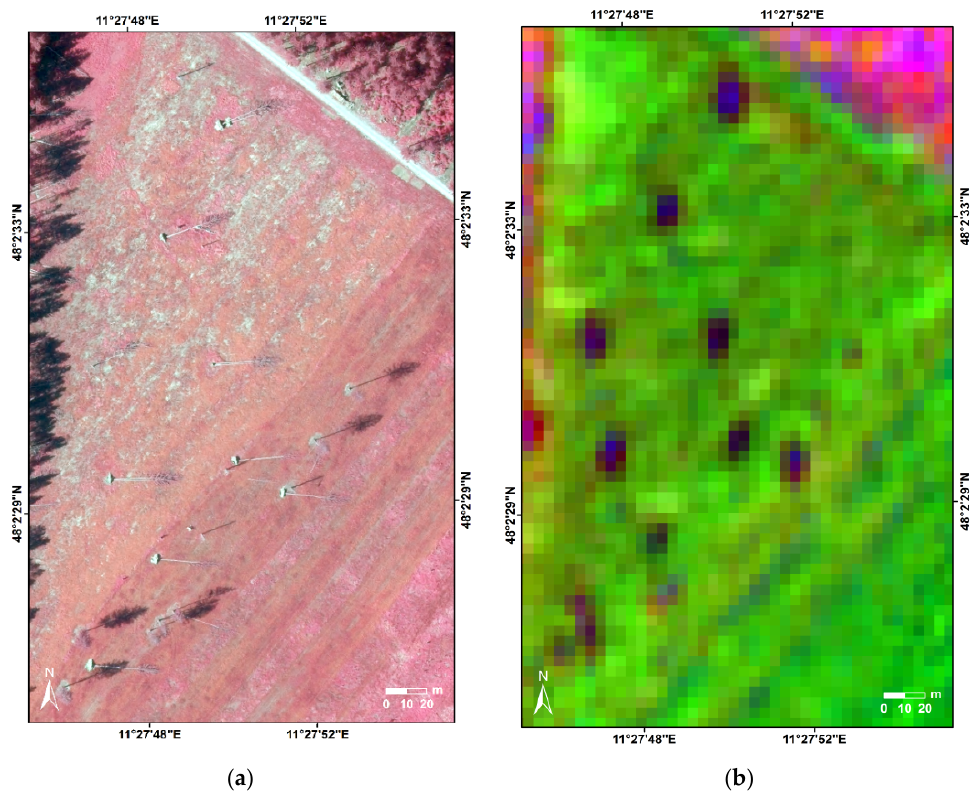
Figure 8. Example of single thrown trees for the Munich South study site ( a ) false color composite orthophoto scene (band combination: near infrared—red—green) showing remaining trees (tree shadows) and thrown trees (dead trees with root plates); ( b ) Pixel ‐ based results based on RapidEye data where single fallen trees appear in blue.